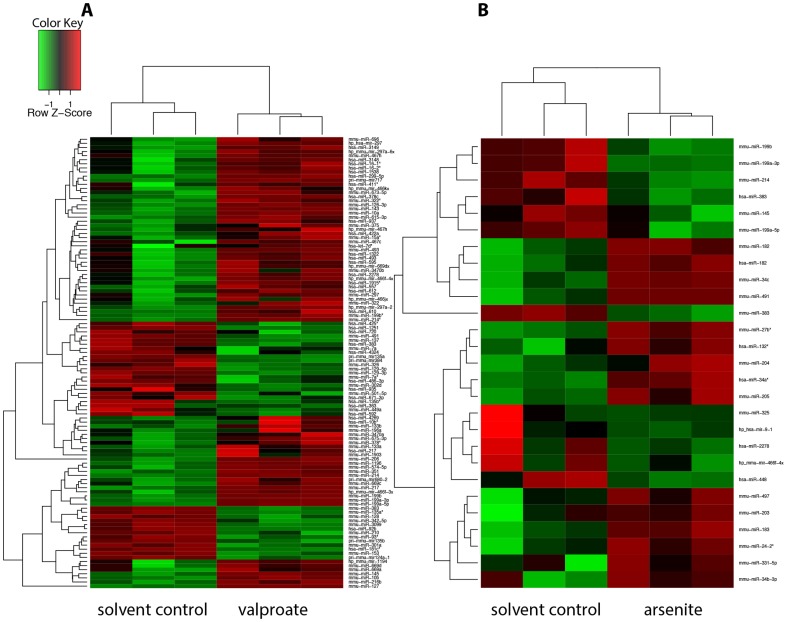
Hierarchical cluster analysis (HCA) of miRNA expression in treated and control samples.HCA was carried out using Euclidian algorithm to build the cluster tree of the average significantly altered miRNAs by VPA or arsenite in comparison to negative/solvent control (NC) in neural- differentiated ESCs. The miRNA expression intensities of all probe set IDs are scaled as a Z-score (all microarray experiments were done in triplicates). Red color denotes upregulated miRNAs, green color – down regulated miRNAs. A. HCA of miRNAs responding to VPA treatment. B. HCA of miRNAs responding to arsenite treatment.